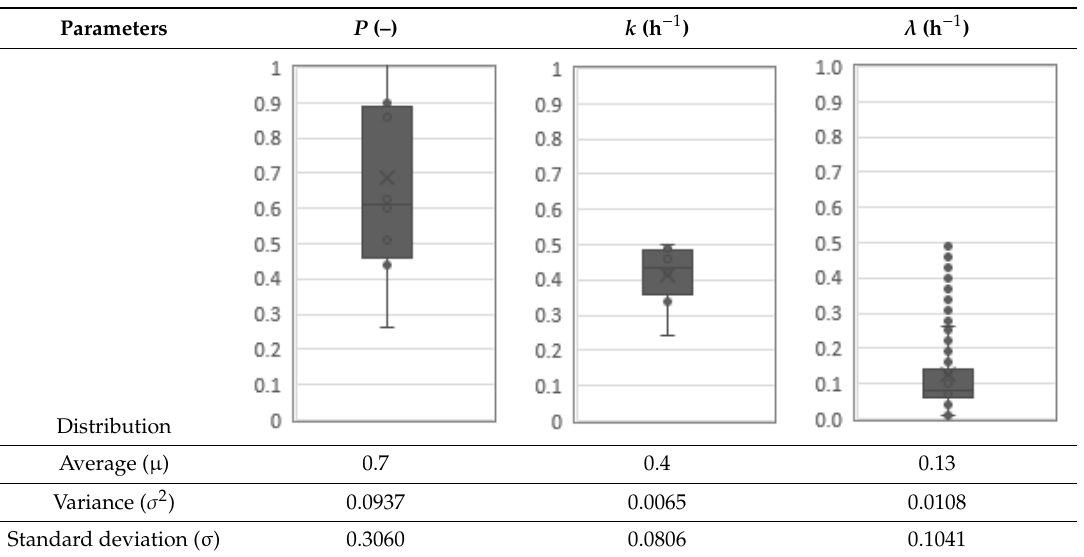
Table 3. Results of P, k, and λ obtained from tests.